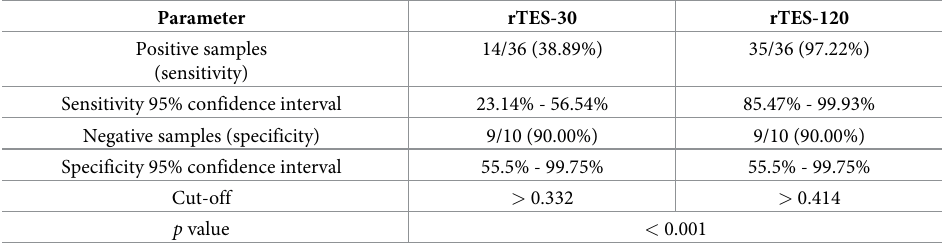
Table 1. ELISA sensitivity and specificity for each recombinant protein as determined by a Receiver Operating Characteristic (ROC) analysis for